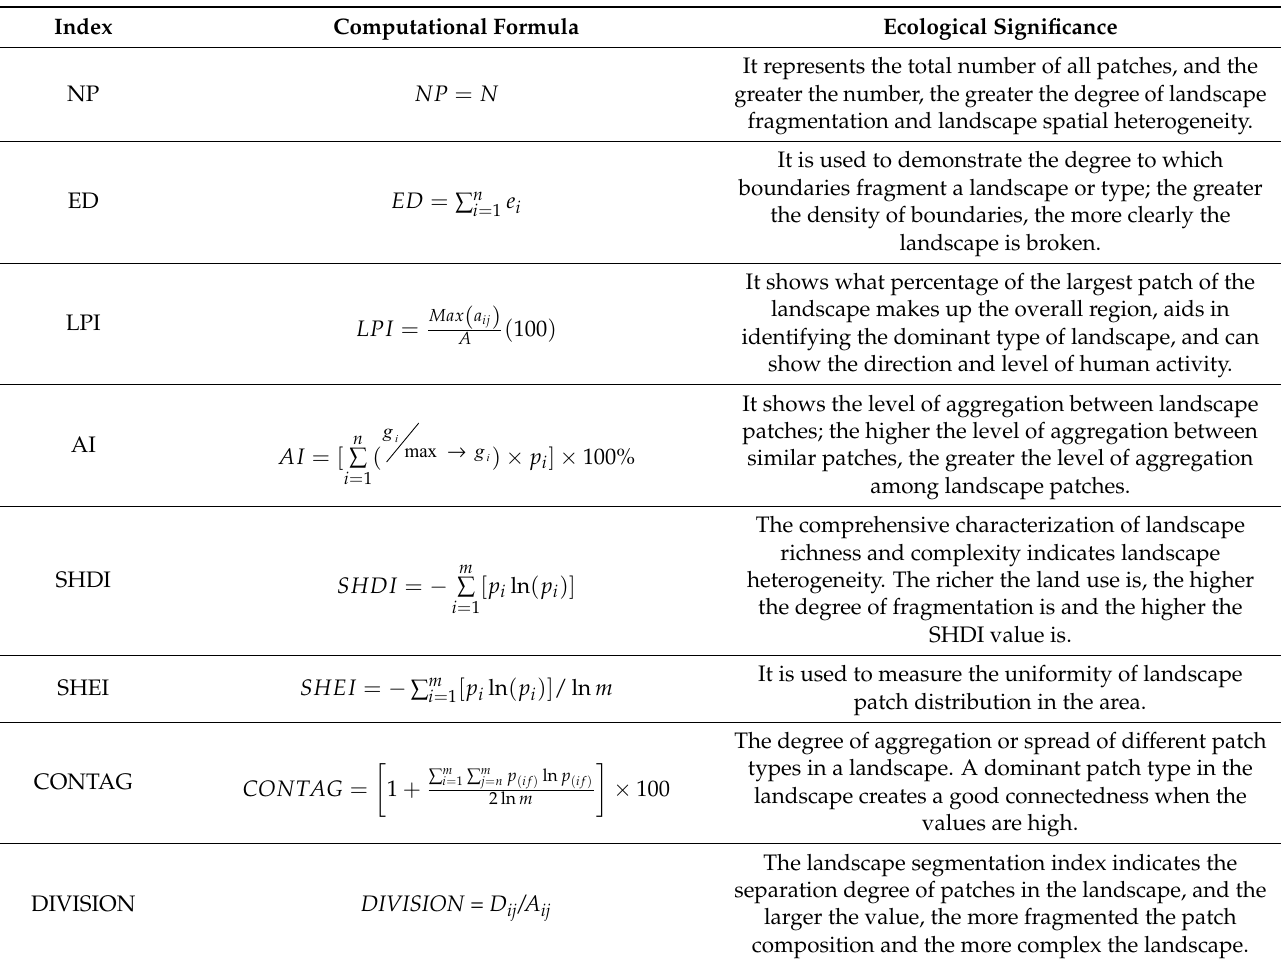
Table 2. Landscape index selection and ecological significance.